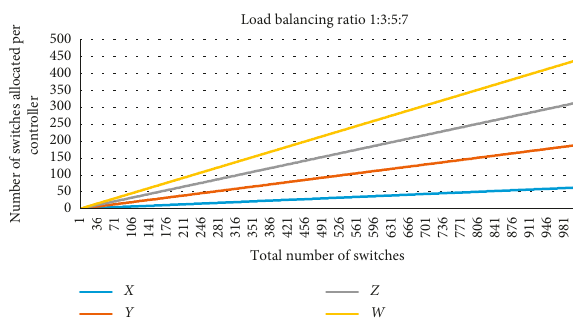
Figure 8: Load balancing for four slave controllers with ratios 1 :3: 5:7.